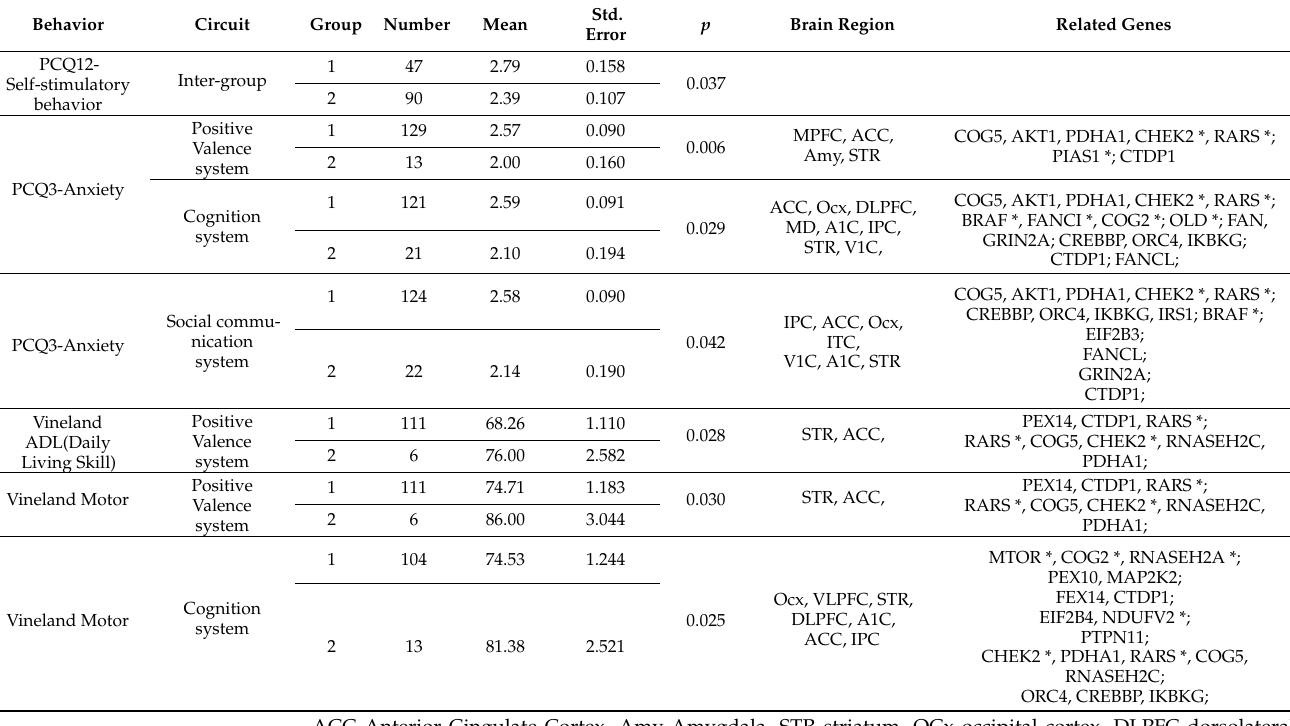
Table 2. Associations Between Gene Variants, Neural Circuits, and Behaviors.